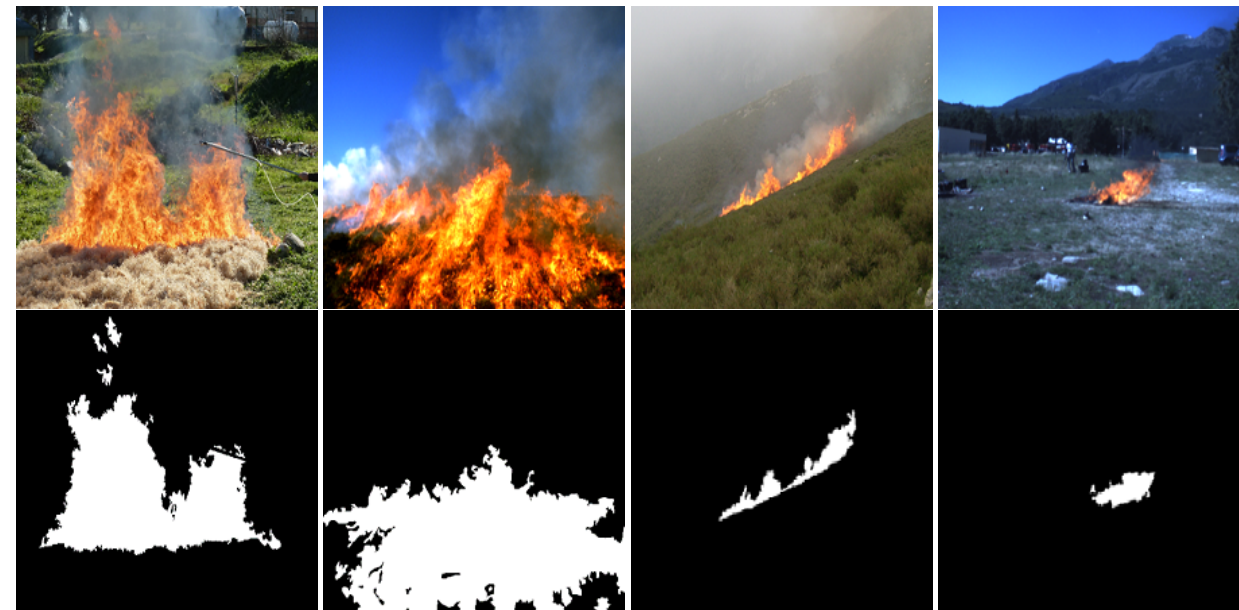
Figure 5. Examples from the CorsicanFire dataset. From ( top ) to ( bottom ): RGB images and their corresponding